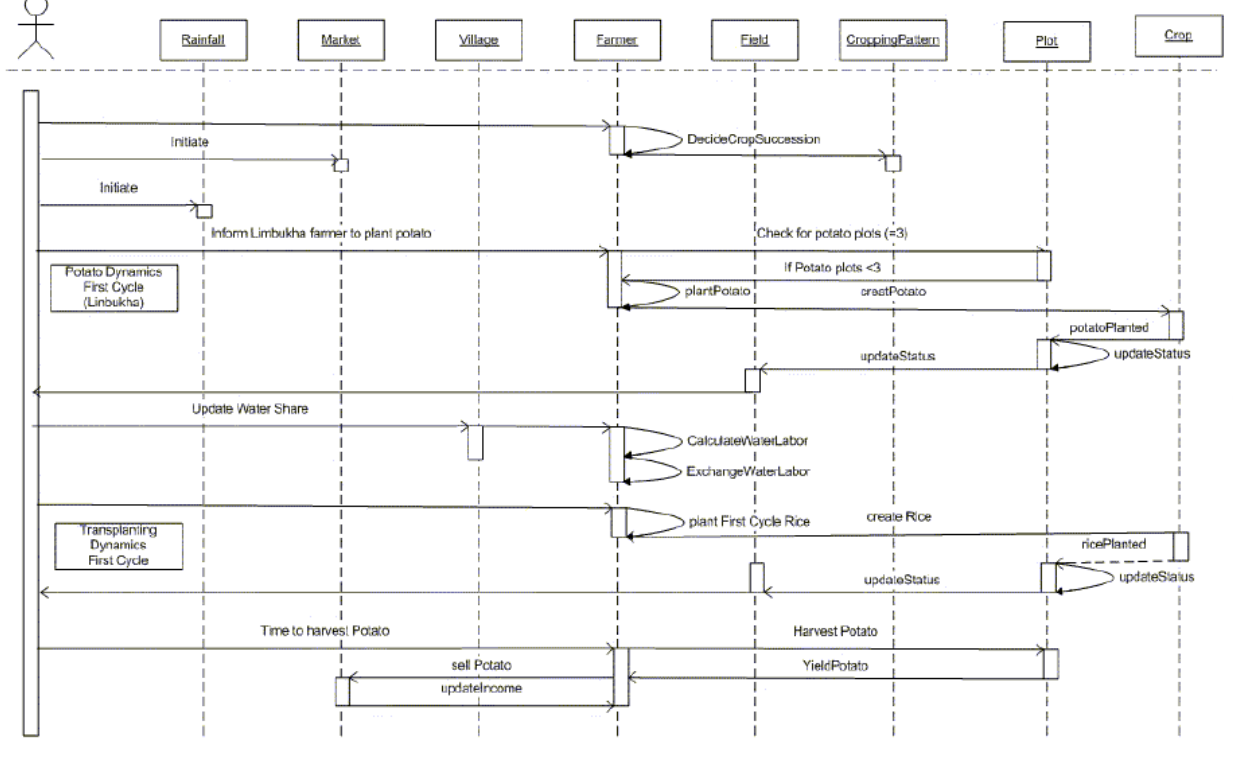
Fig. A2.6. Sequence diagram of Limbukha model (Cycle1 corresponding to January to mid-June).